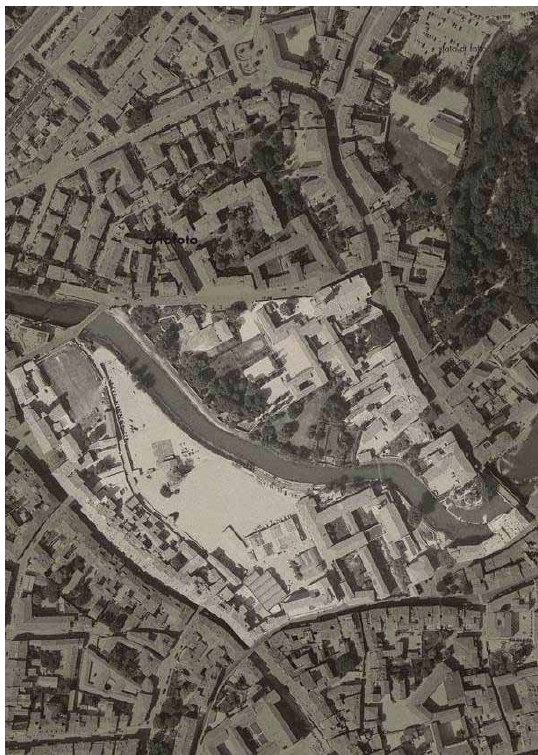
fig. 3b. View of the city walls (Pozzato 2012)